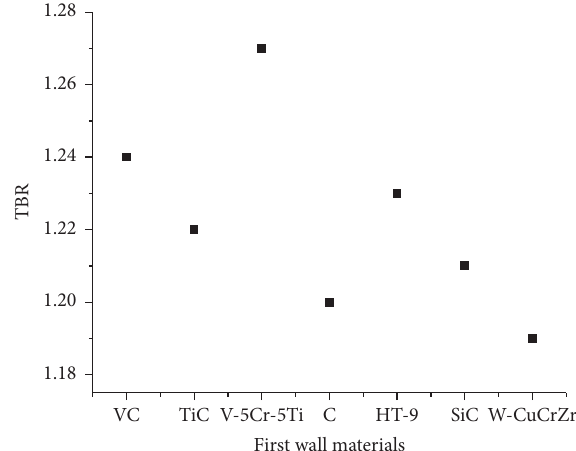
Figure 10: Te frst wall (FW) materially afected tritium breeding capability in the blanket zone.